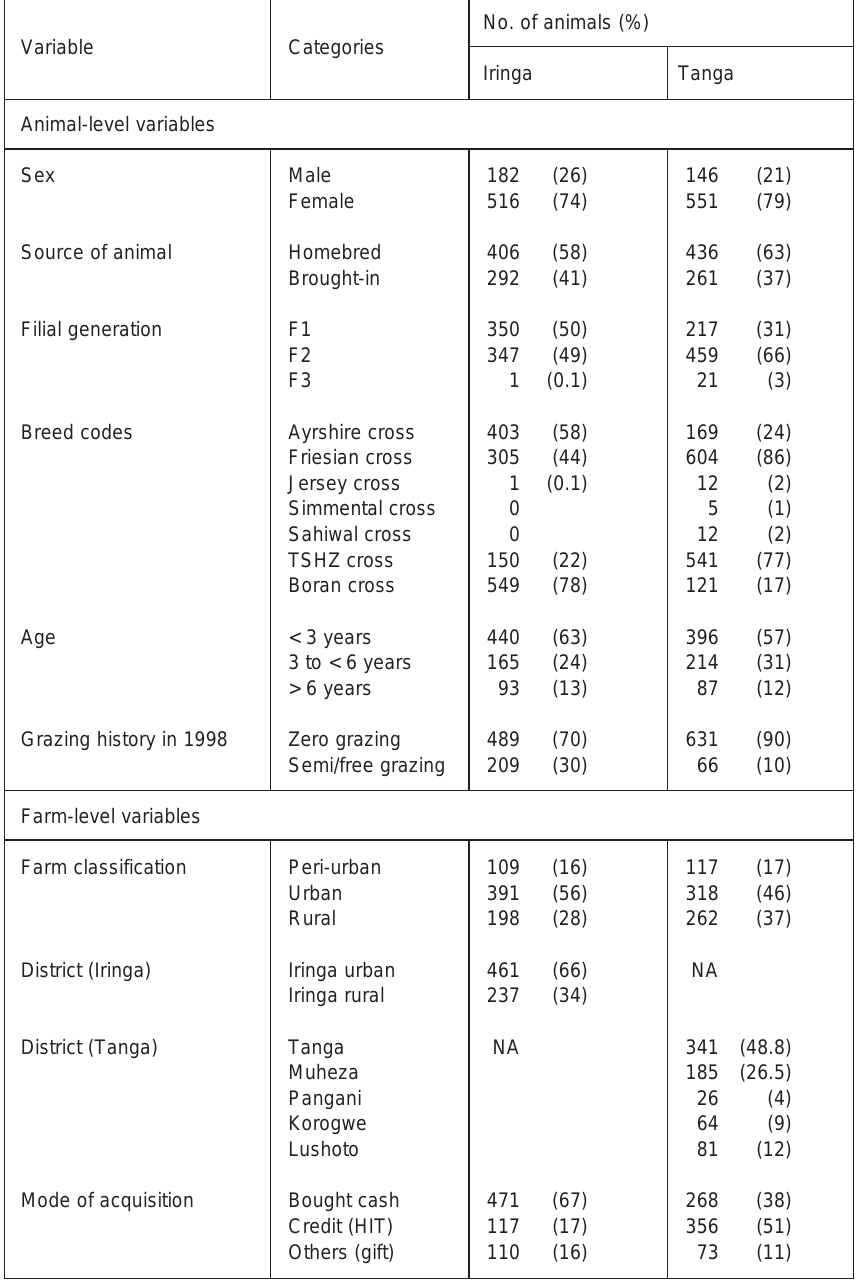
TABLE 1 The proportions of cattle in each category of each variable investigated during the